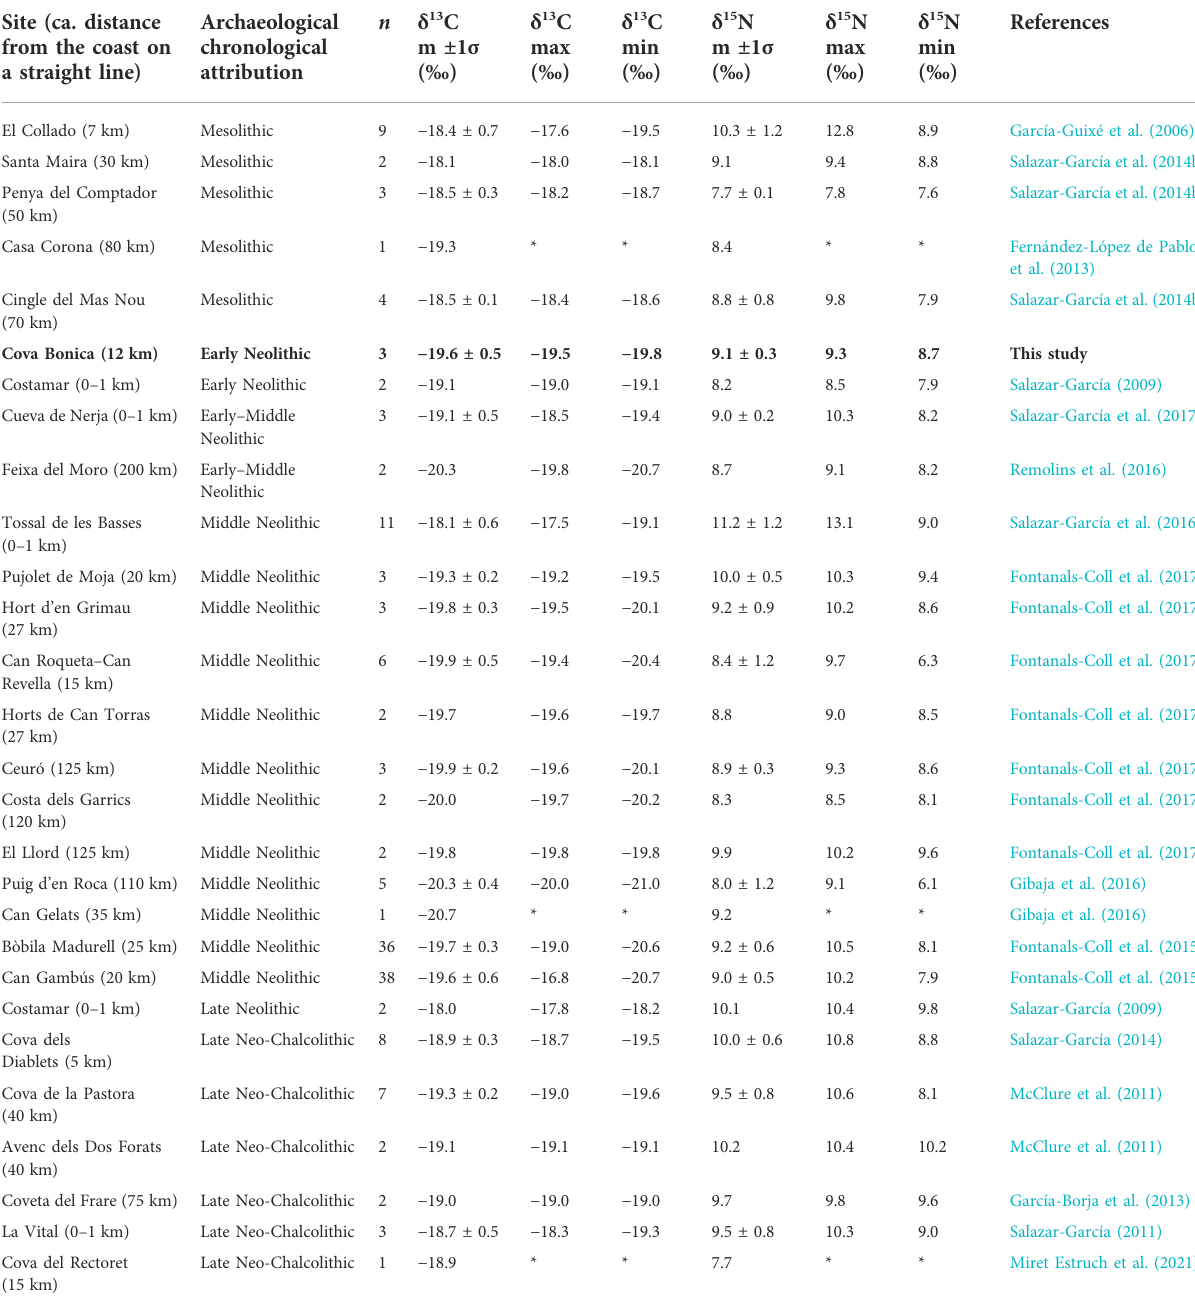
TABLE 4 List ofall Mediterranean Iberiasites with published carbonand nitrogen isotopic ratioanalysis onhuman bone collagen from theMesolithic up to the Late Neolithic – Chalcolithic period. Only samples from human adults for which both C and N results are available which meet collagen quality controls have been considered